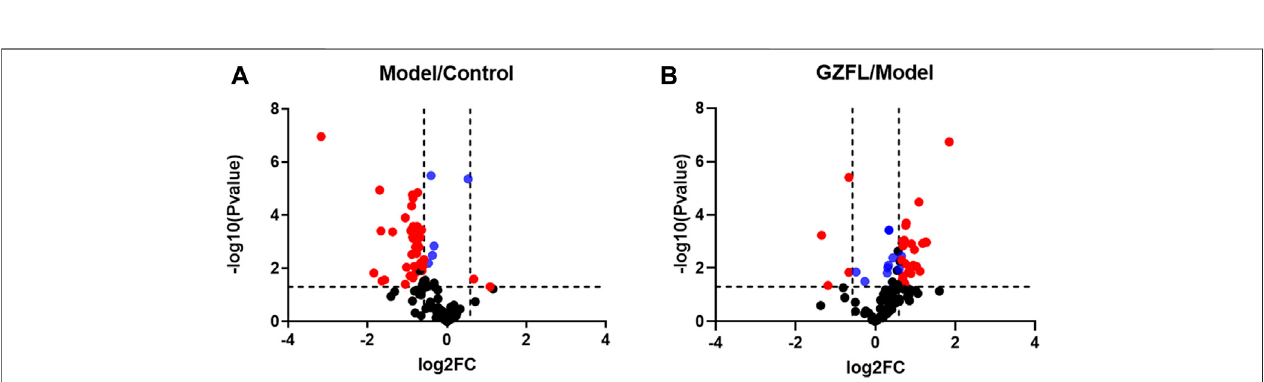
FIGURE 8 | Volcano plots of compounds detected in uterine tissue for metabolomics analysis (A) Volcano plot for Model group versus Control group (B) Volcano plotforGuizhiFulingCapsulesadministrationgroup(GZFL)versusModelgroup.Take|FC| (cid:2) 1.5and p -value (cid:2) 0.05asthetruncationstandard.Theblackdotsrepresent compoundswithnosigni fi cantdifference,thereddotsarecompoundswithadifferentialexpressionfoldgreaterthan1.5times,andthebluedotsrepresentcompounds with a signi fi cant difference but a fold change of less than 1.5 times.